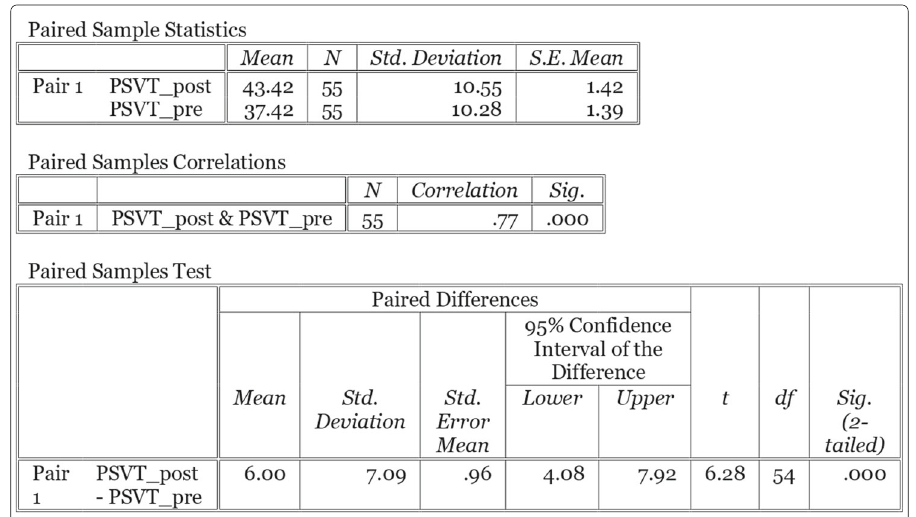
Fig. 17 Paired t-Test (2-tailed) for morning groups of Computer